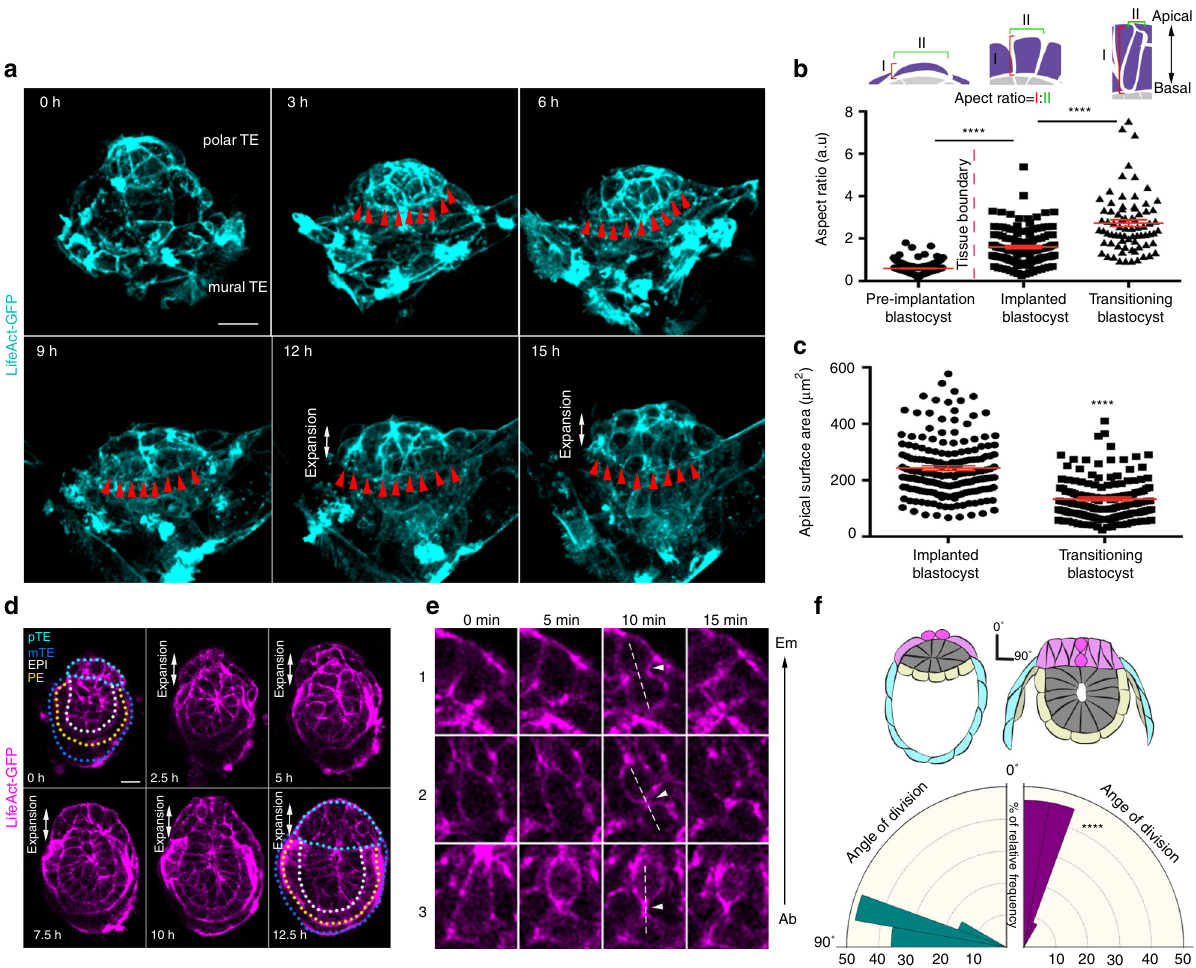
Fig. 3 Cell shape changes and polarized cell divisions drive polar TE expansion. a Stills from a time lapse movie of Lifeact-GFP blastocyst. Red arrowheads indicate the polar/mural TE boundary. Boundary formation is followed by polar TE expansion. b Quanti fi cation of polar TE cell aspect ratio at different developmental stages. Two-sided unpaired student ’ s t test; **** P < 0.0001; mean ± SEM. Pre-implantation blastocyst: n = 216 cells; Implanted blastocyst: n = 152 cells; Transitioning blastocyst; n = 75 cells. c Quanti fi cation of polar TE apical cell surface are. Two-sided unpaired student ’ s t test; **** P < 0.0001; mean ± SEM. Blastocyst before: n = 186 cells; Transitioning blastocyst; n = 163 cells. d Stills from a time lapse movie of Lifeact-GFP implanted blastocyst. Polar TE expansion is evident at 2.5 h upon polar TE cell shape changes and polarised cell division. e Representative examples of polar TE cells dividing parallel to Embryonic(Em)/Abembryonic(Ab) axis during polar TE expansion. f Rose diagram for quanti fi cation of cell division orientation in blastocysts before (green) and during (purple) polar TE expansion. Kolmogorov – Smirnov test: **** p < 0.0001. Blastocyst before polar TE expansion: n = 24, Bastocyst during polar TE expansion: n = 36. Source data are provided as a Source Data fi le. Scale bars = 20 µ